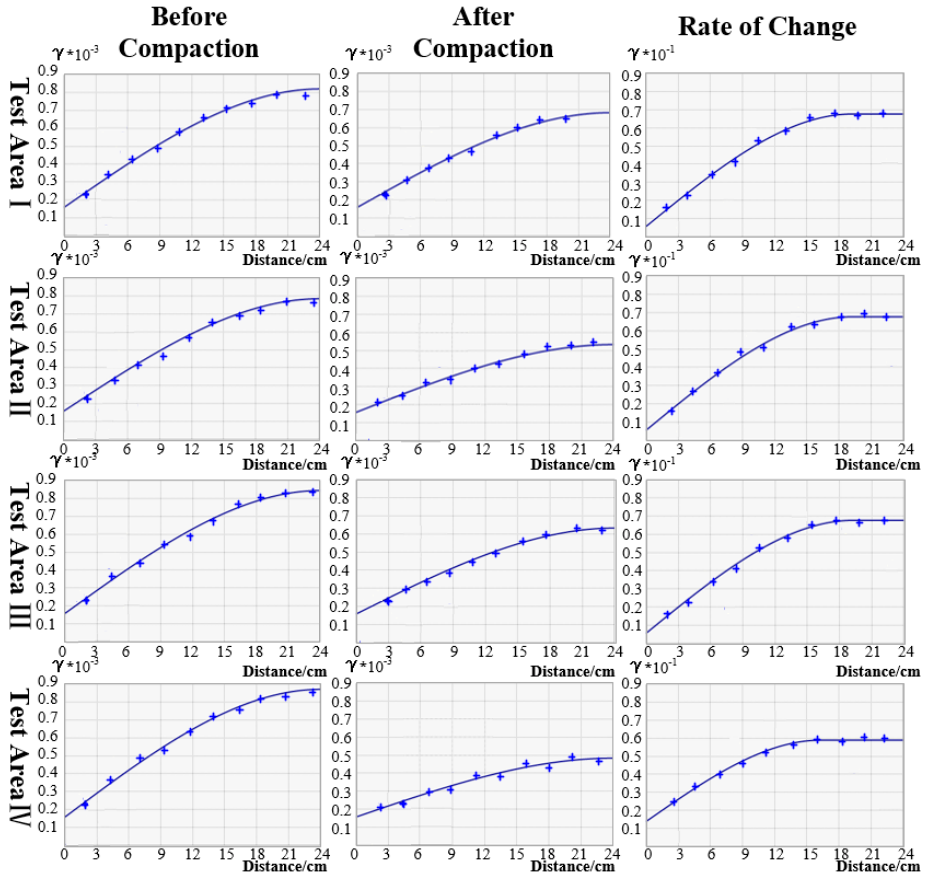
Figure 5. Longitudinal spatial semi − variance function of soil water content in each test area.